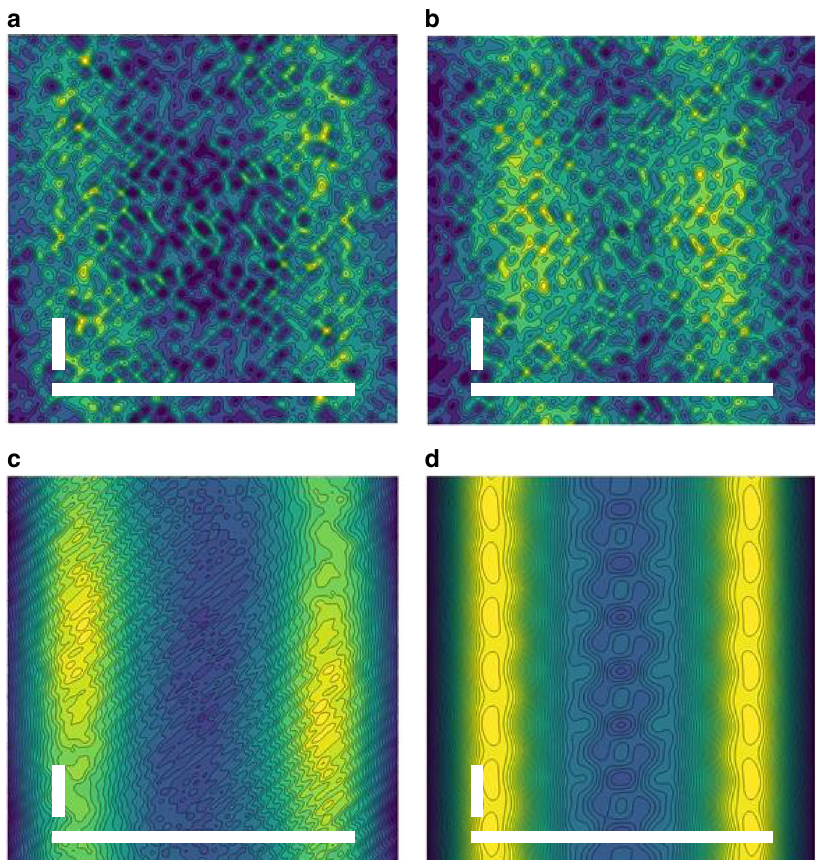
Fig. 5 Projection images recovered by iterative phase retrieval. a 2D projection image of microtubule samples recovered after Fourier transform of the image in Fig. 2a using a featureless tube for initial phase and after 100 cycles of iterative phase retrieval. b 2D projection image recovered after 100 cycles of iterative phase retrieval of the image shown in Fig. 2b. c 2D projection image recovered after 100 cycles of iterative phase retrieval of the image shown in Fig 2c. d 2D projection image recovered after 100 cycles of iterative phase retrieval of the image shown in Fig. 2d. These projection images shows increasing detail after each processing step. Both the average microtubule diameter of approximately 25 nm and sub-structures of 4 nm become visible when inverting the fi tted diffraction image. White bars indicate 25 nm in the horizontal direction and 4 nm in the vertical direction. Blue represents low projection density whereas yellow is high projection